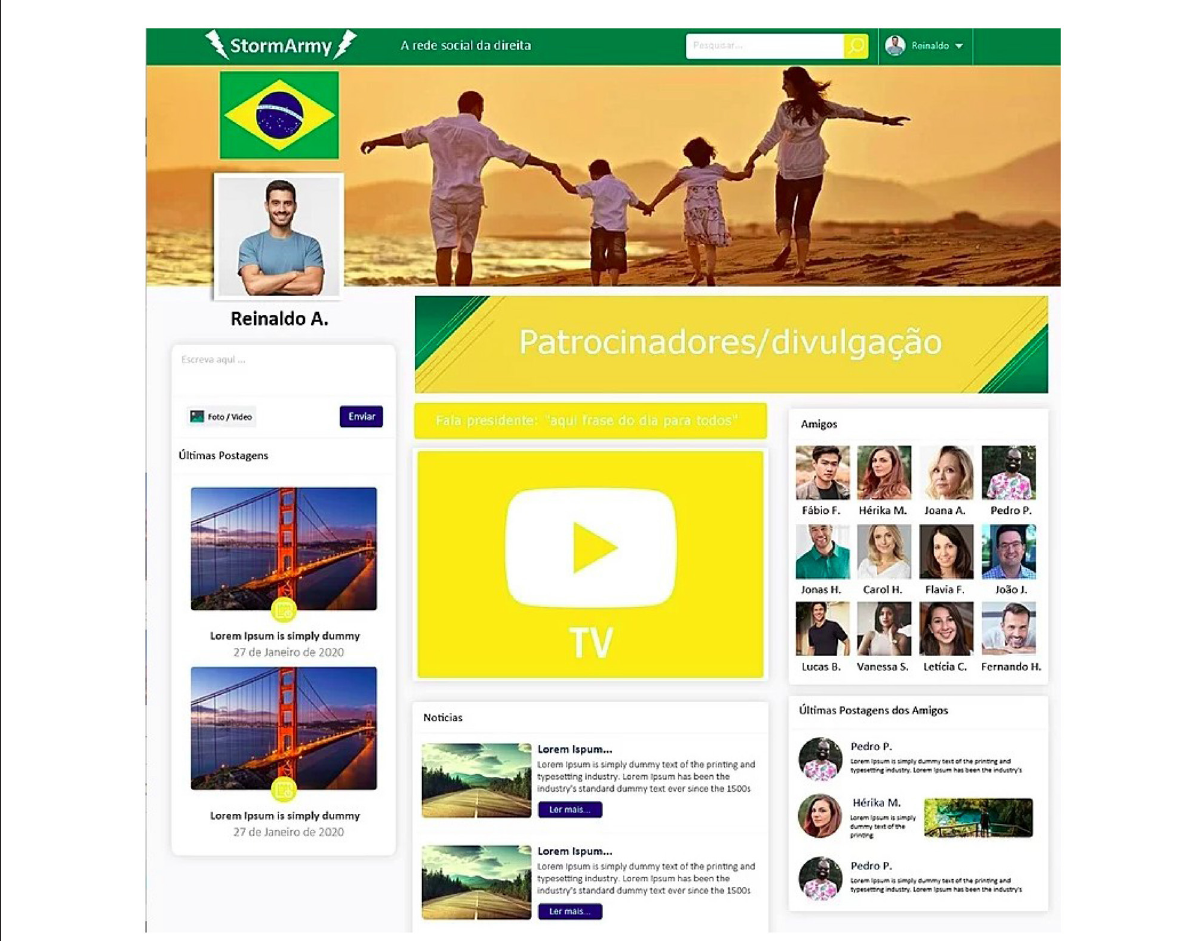
FIGURE4 Screenshot of “Storm Army,” a right-wing social media that the channel Hidrogênio Global tried to create through a crowdfunding campaign.